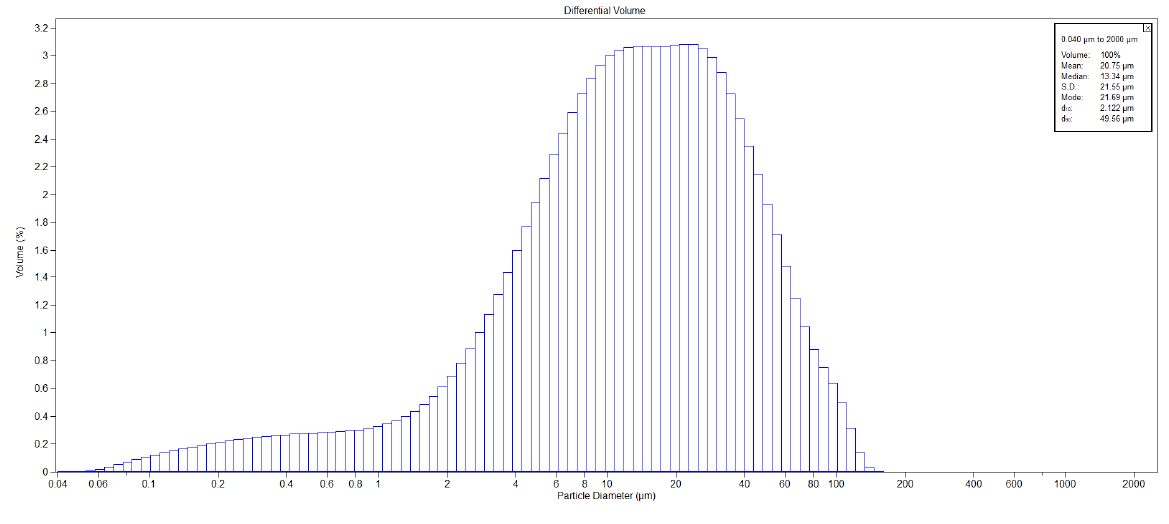
Figure 1. Wastepaper sludge ash.